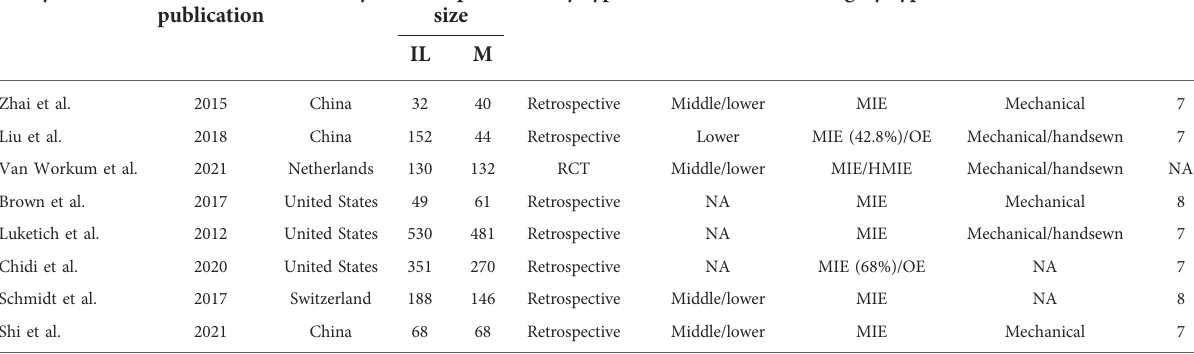
Study type Tumor location Surgery type Anastomosis details NOS size